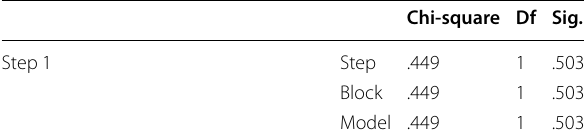
Table I: Omnibus tests of model coefficients for people orientation culture